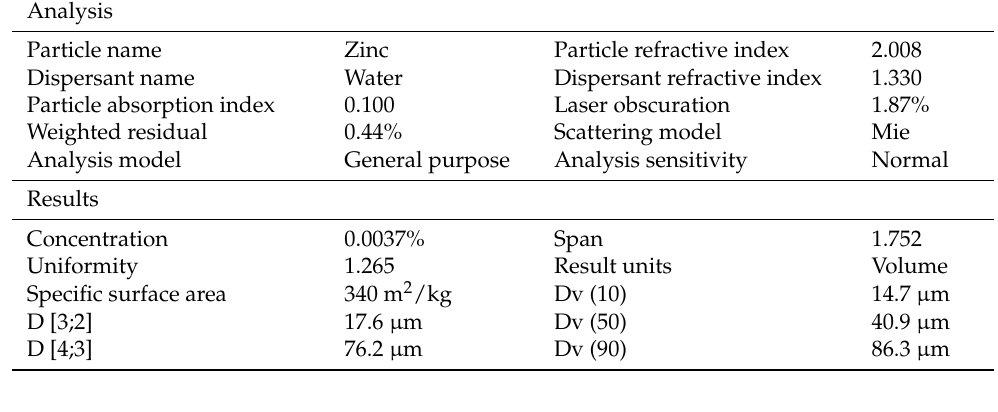
Figure 9. A photo documentation of the zinc product segregated on a stainless plate after electrol- ysis—sample H22. Condition at the electrolysis: cathode—stainless plate, anode—nickel plate,